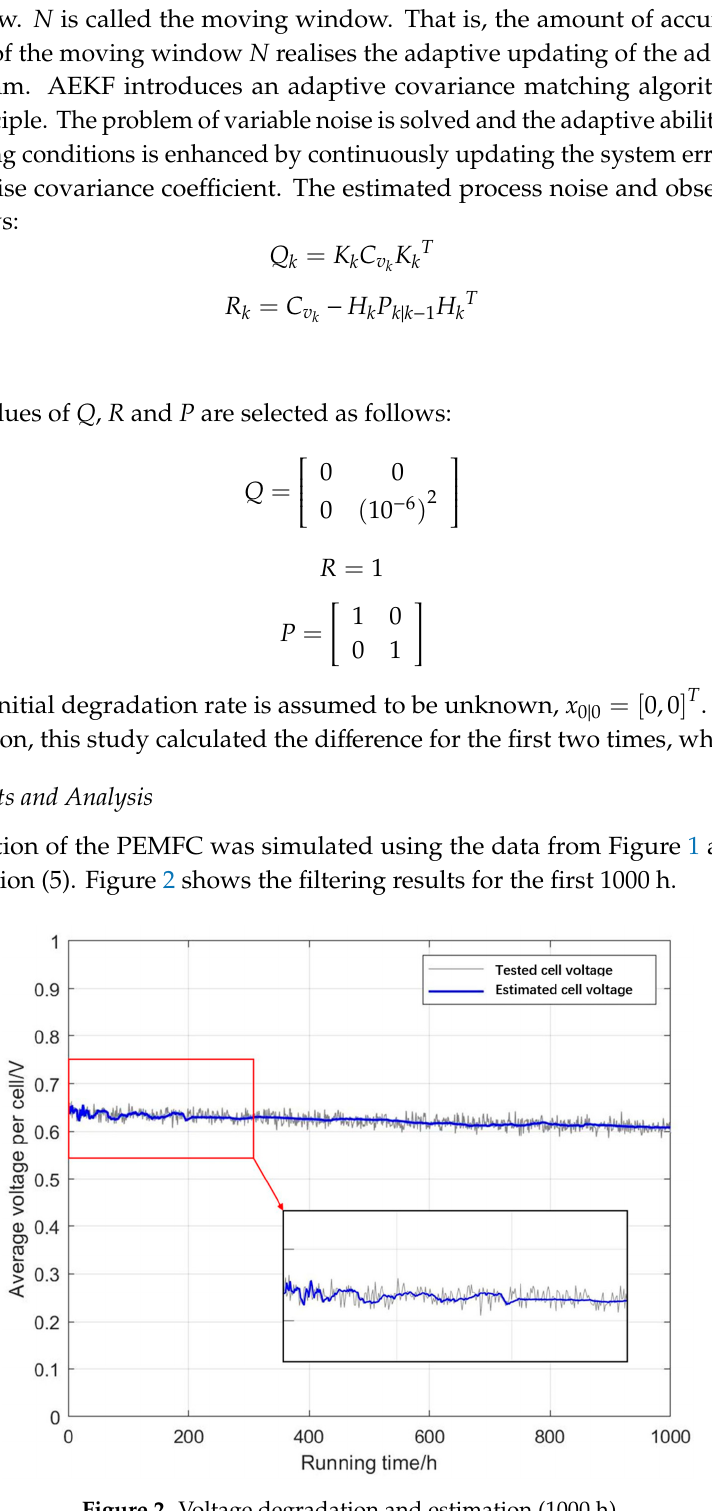
Figure 2. Voltage degradation and estimation (1000 h).